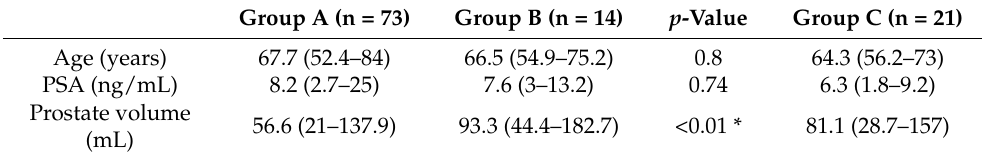
Table 2. Age, PSA, and prostate volume distribution in the three groups of patients. Prostate volume is significantly (* p < 0.01) different between group A and group B.